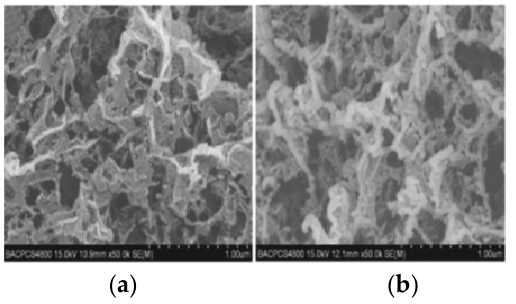
Figure 1. SEM images of graphene ( a ) and AP/graphene nanocomposites ( b ). Reprinted from ref.